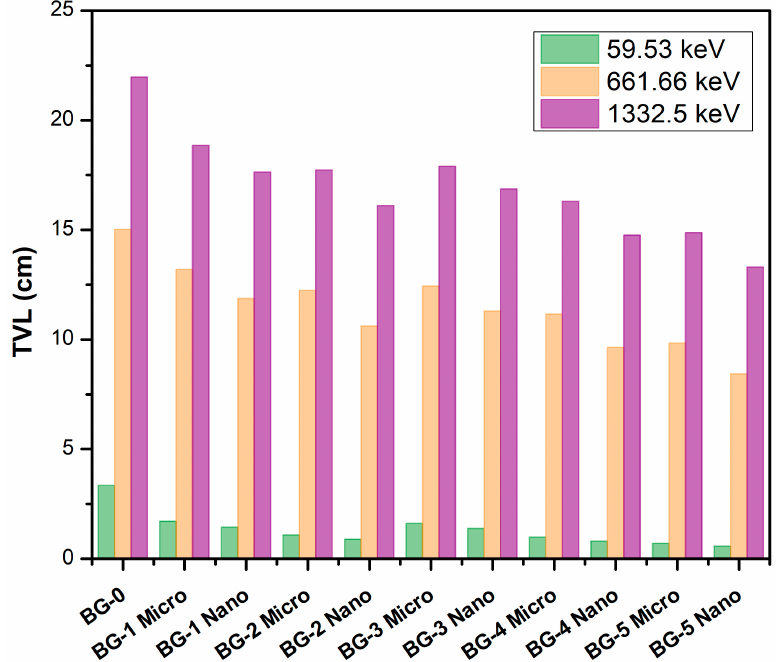
Figure 5. The tenth-value layer (TVL) of the Bi 2 O 3 /bentonite–gypsum composites at photon energies of 59.53, 661.66, and 1332.5 keV.